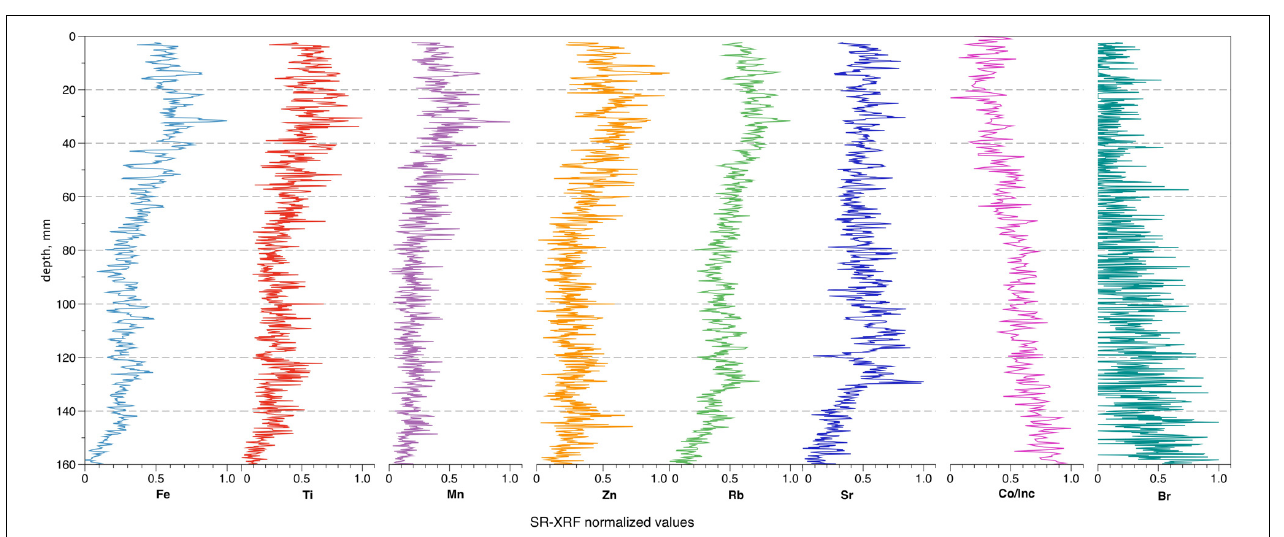
FIGURE 3 | Core LDOPC12-1.